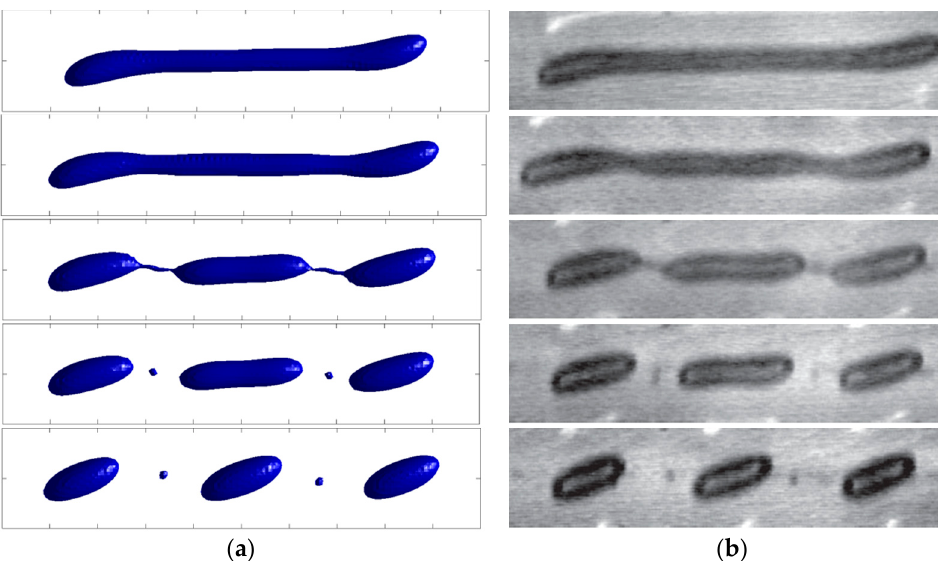
Figure 18. The evolution of the drop shape with the diameter of 2 R drop = 0.7 H and the Capillary number of Ca = 0.46, ( a ): Generated in the present research, ( b ): Reported by Sibillo et al. [34], (Reproduced with permission from physical review letters; published by the American Physical Society, 2006).